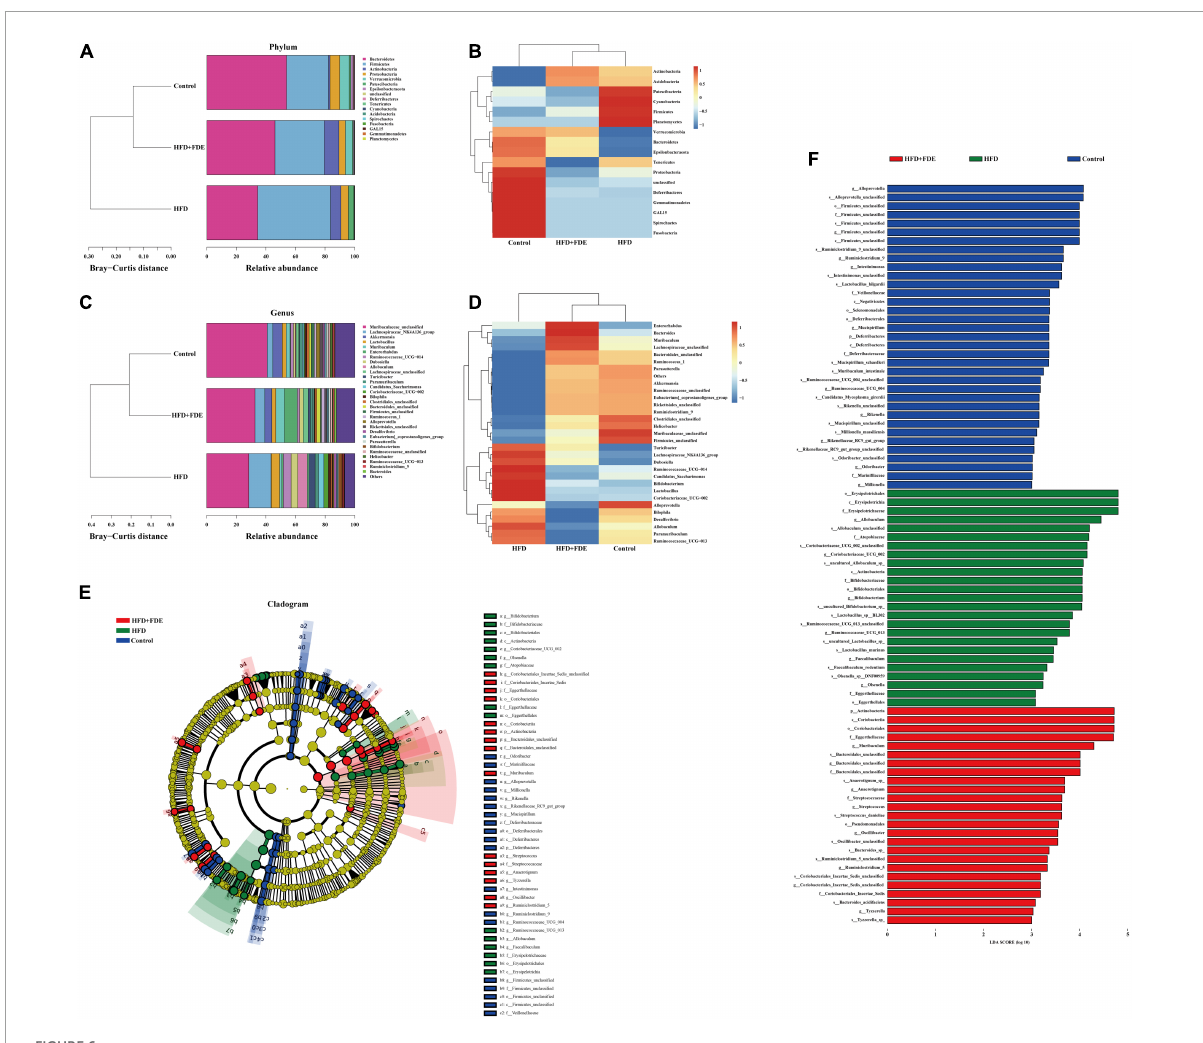
FIGURE6 The relative abundance of intestinal flora in each group. (A) The relative abundance distribution map at the phylum level of each group. (B) Taxa heatmap at the phylum level. In the heatmap, the gradient from blue to red reflects the change from low to high abundance. (C) The relative abundance distribution map at the genus level of each group. (D) Taxa heatmap at the genus level. (E) Hierarchical tree diagram of LEfSe multilevel species, showing the taxonomy of the gut microbiota and its main bacterial structure. Circles radiating from the inside to the outside represent the phylum, class, order, family, genus. At different classification levels, each small circle represents a classification at that level. The diameter of the small circles is proportional to the relative abundance. Species with significantly different abundances between groups are colored in groups, while species with no significant differences are colored yellow. (F) Bar graph of LDA discriminant results, where the LDA value is > 3.0 and the length of the bar graph represents the LDA value. n = 5–6 per group. Control, normal diet; HFD, high-fat diet; Control + FDE, a mixture of FDE and normal diet; HFD + FDE, a mixture of FDE and high-fat